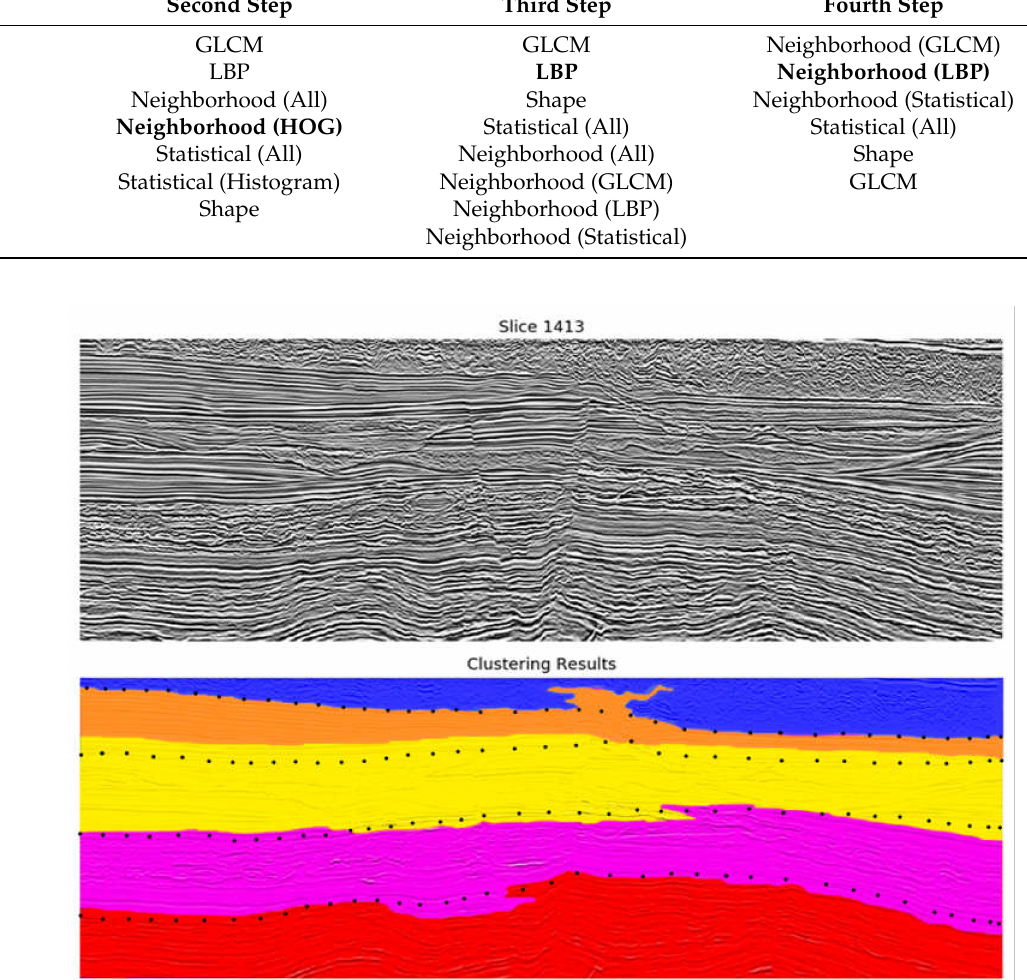
Figure 16. Results from the clustering of Watershed segments using k-Means (5 groups) with the best subset of features. The top image shows the original vertical seismic slice; the bottom one shows the Watershed results. Comparing this result with Figures 13–15, it can be concluded that the accuracy of the model was